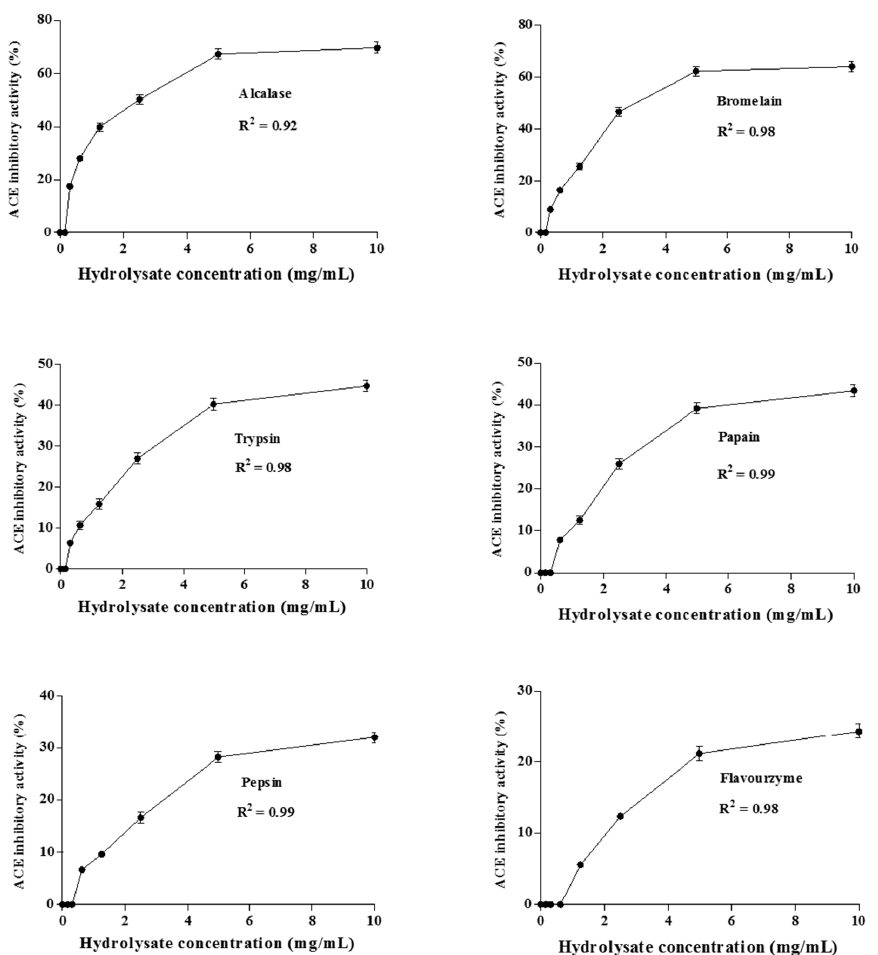
Figure 2. ACE inhibitory activities (%) of A. lecanora hydrolysates at different concentrations between 0.0 and 10.0 mg of dry weight/mL. Results represent the means ± SD of three replications.